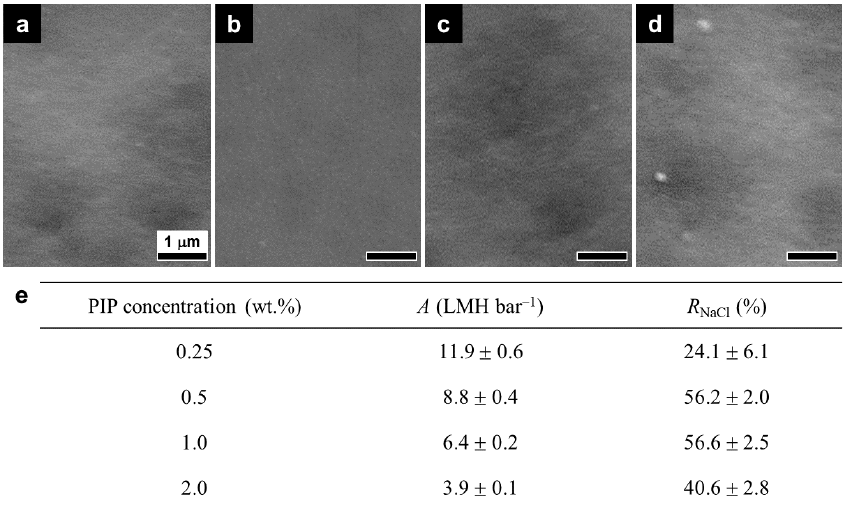
Figure 2. Surface morphologies and RO performance of the PIPA interlayers prepared with various PIP concentrations. ( a – d ) SEM surface images and ( e ) water permeance ( A ) and NaCl rejection ( R NaCl ) of the PIPA interlayers prepared at 0.1 wt.% TMC with different PIP concentrations: ( a ) 0.25, ( b ) 0.5, ( c ) 1.0, and ( d ) 2.0 wt.% PIP.